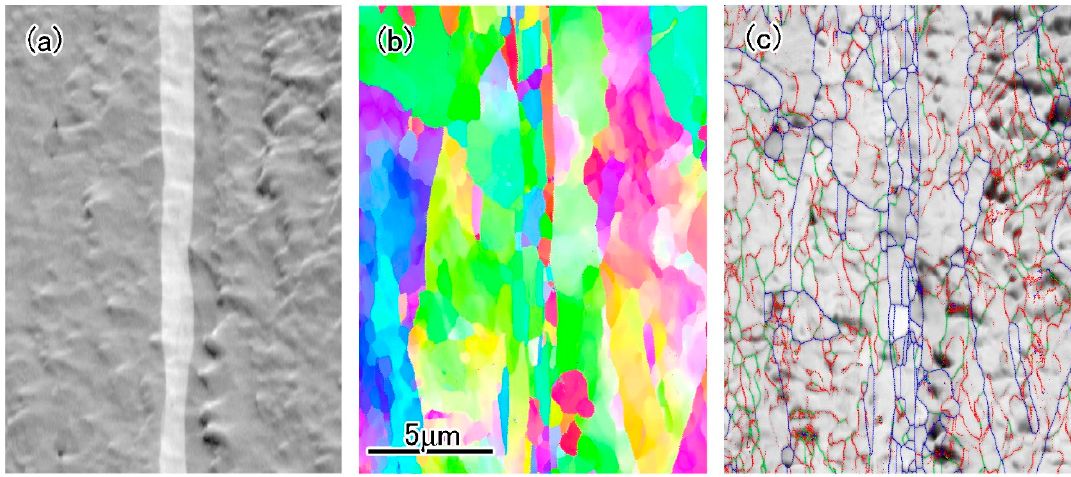
Figure 13. ( a ) SEM image around the interface between wires. ( b ) IPF map and ( c ) EBSD grain boundary map taken at the interface.